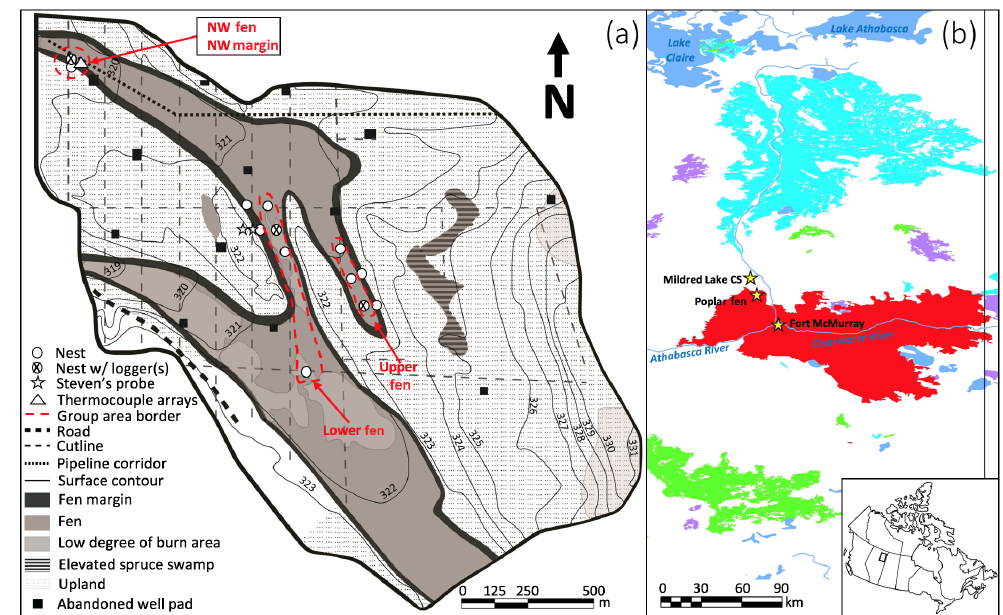
Figure 1. Map of the Poplar Fen watershed ( a ; 56 ◦ 56 (cid:48) N, 111 ◦ 32 (cid:48) W). The entire area was burned with the exception of areas highlighted in light grey. Included is an inset of northeastern boreal Alberta (b) showing the burned area during years of high spring fire frequency, including 1998 (purple), 2002 (green), 2011 (cyan), and 2016